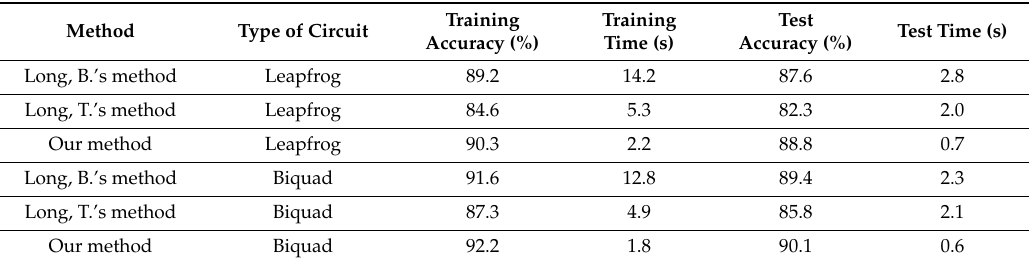
Table 7. Training and test accuracies of soft and hard faults in two Table 6. Training and test accuracies of soft fault of Leapfrog circuit.